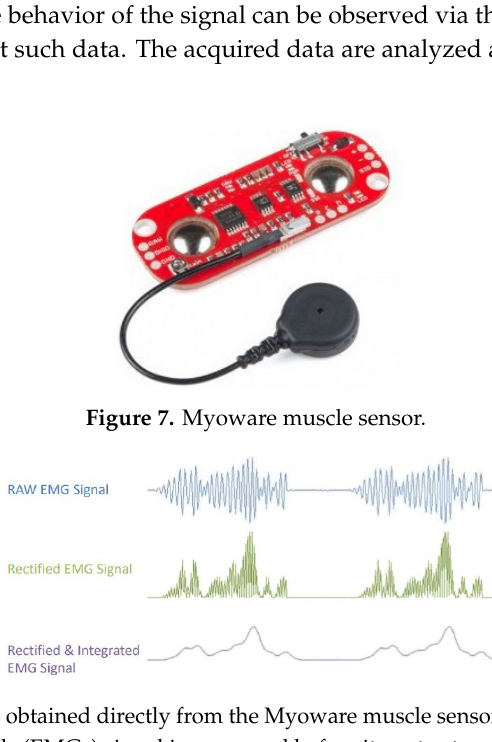
Figure 10. Samples that are related to the upward movement. The Y -axis represents each sampling point of the vector that is related to each sample and the X -axis represents the signal amplitude (it was mapped between 0 and 5).